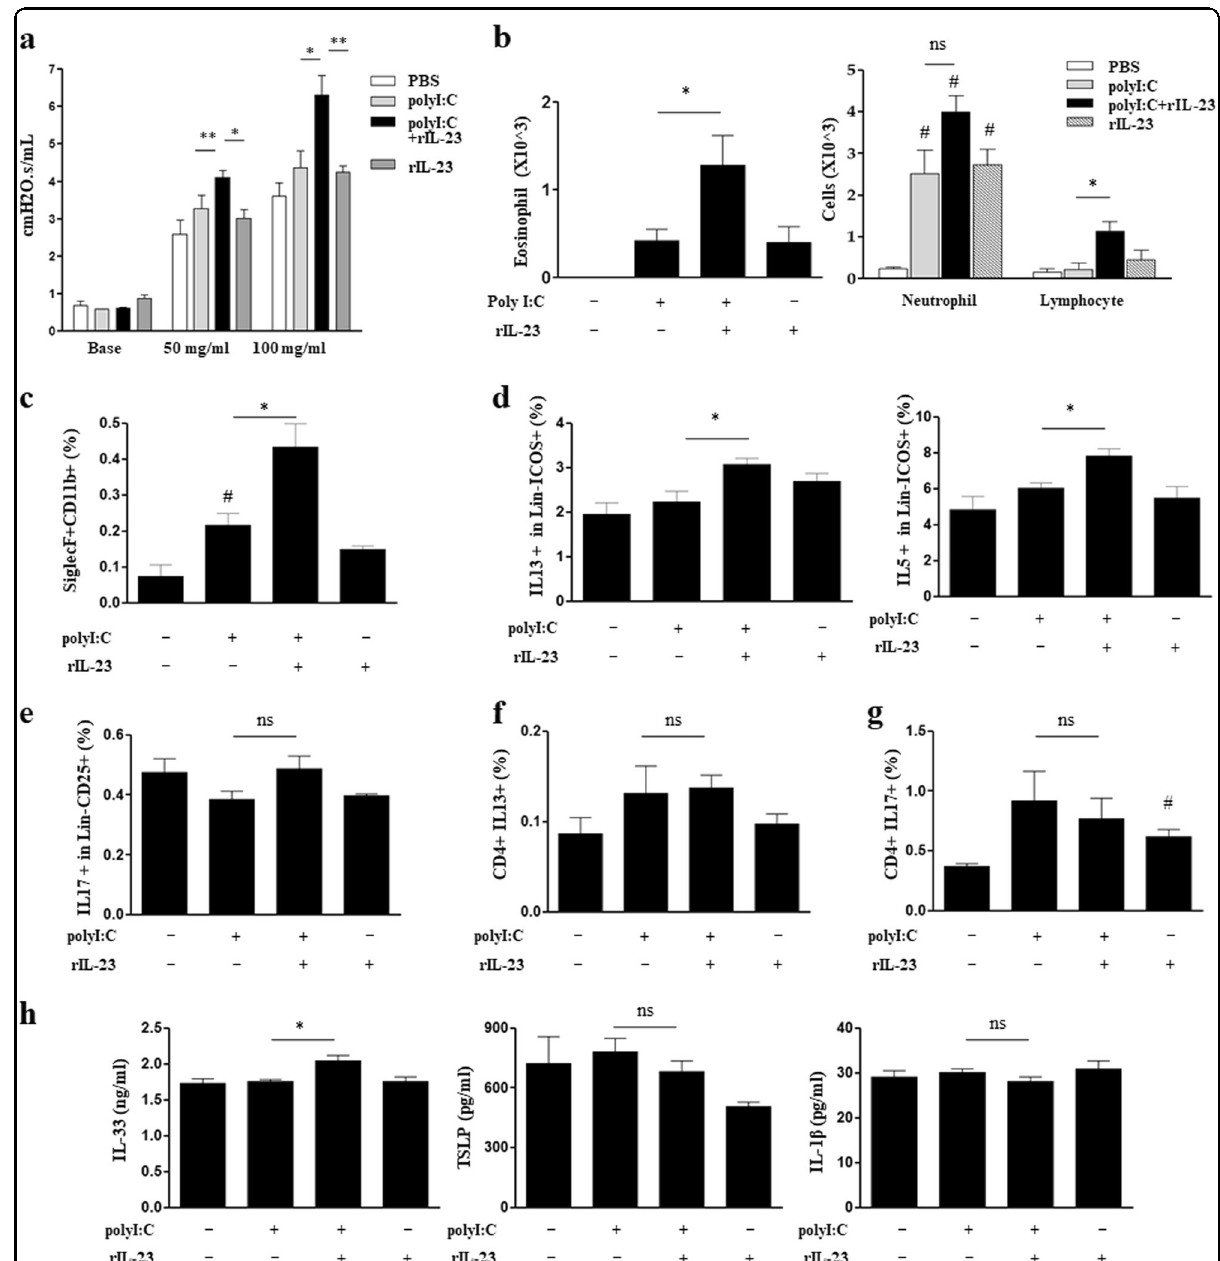
Fig. 2 Nonallergic eosinophilic asthma phenotype of the polyI:C/rIL-23 model. a Airway resistance at doses of 50 and 100 mg/mL methacholine (MCh). b Eosinophils, neutrophils, and lymphocytes in bronchoalveolar lavage fl uid. c CD11b + siglecF + CD11c − cells in bronchoalveolar lavage fl uid. d IL-13-producing or IL-5-producing type 2 innate lymphoid cells (CD45 + Lin − ICOS + ) in lung homogenate. e IL-17A-producing type 3 innate lymphoid cells (CD45 + Lin − CD25 + ) in lung homogenate. f , g IL-13-producing or IL-17A-producing CD4 + T cells in lung homogenate. h IL-33, TSLP, and IL-1 β levels in lung homogenate. * P < 0.05, ** P < 0.01 between two groups; # P < 0.05 compared to the control group; ns, not signi fi cant; PBS phosphate-buffered